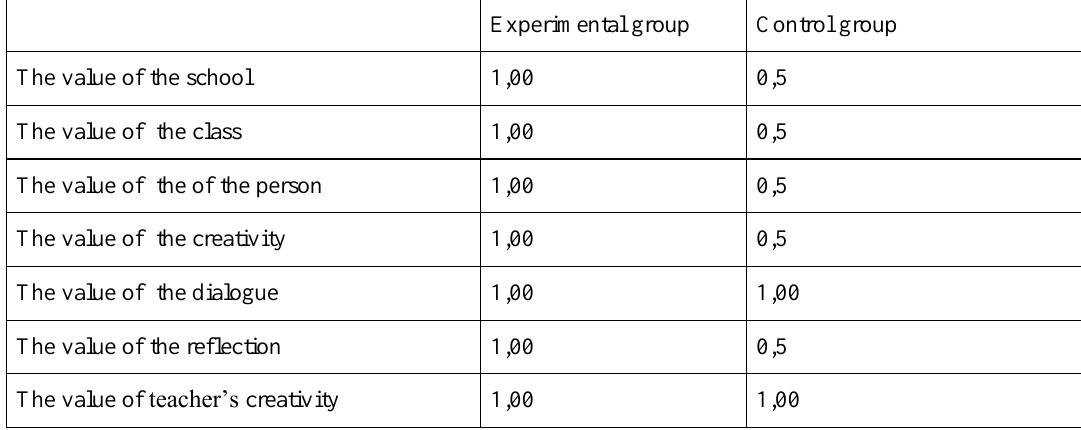
Experimental group Control